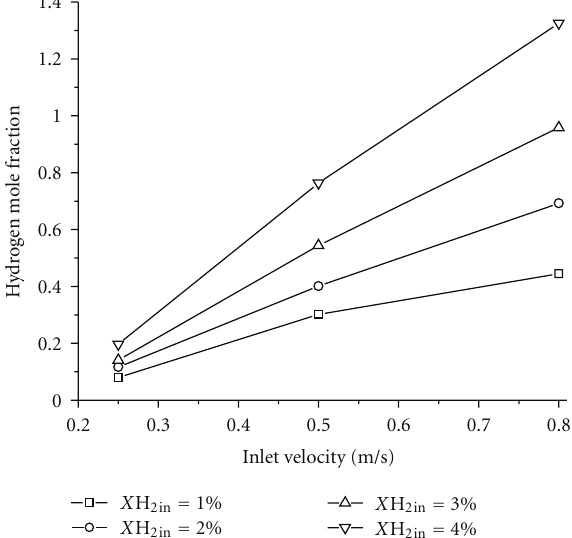
Figure 11: Outlet hydrogen concentration as a function of inlet velocity and inlet hydrogen concentration for REKO facility with inlet temperature 298 K.